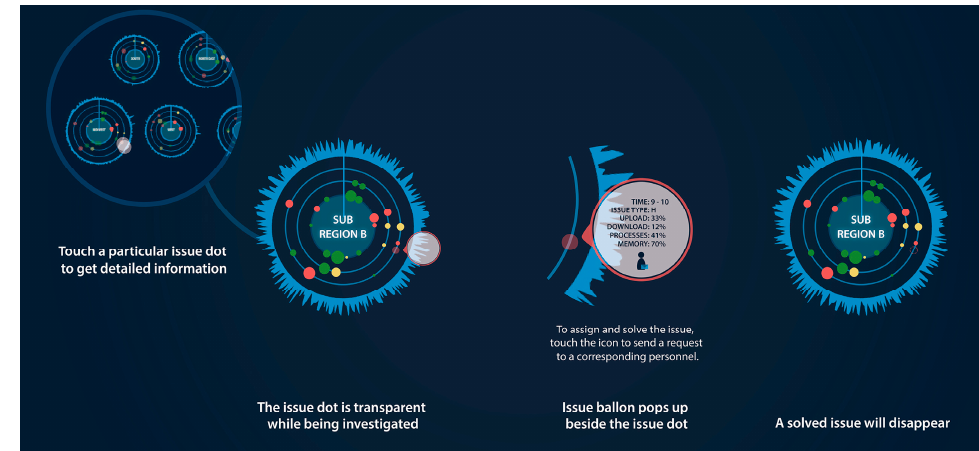
F igure 8. Investigation of an issue through direct interaction. Figure 8. Investigation of an issue through direct